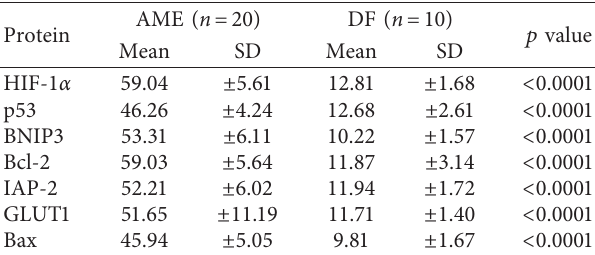
Table 1: The p values of HIF-1 α , p53, BNIP3, Bcl-2, IAP-2, GLUT1, and Bax with expression in AMB and DF, Student’s t , and Man- n–Whitney